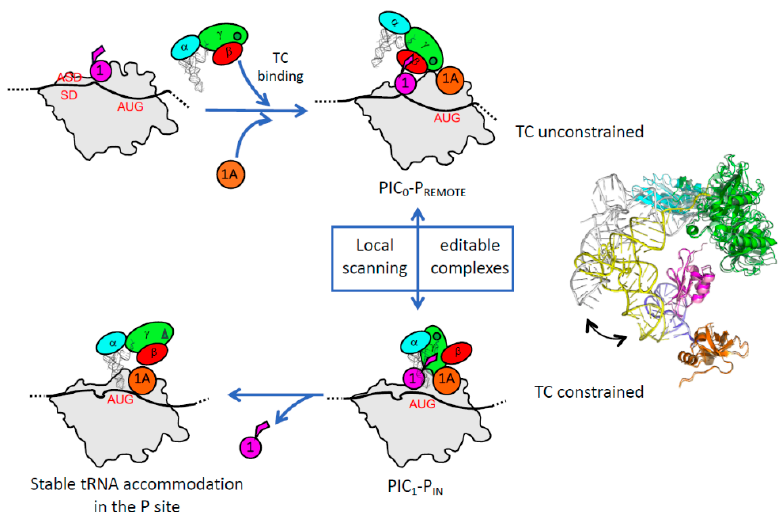
Figure 5. Local scanning for the start codon selection in archaea. The figure schematizes the different steps of the start codon selection for SD containing archaeal mRNAs. Note that aIF1 facilitates the mRNA binding [72,145]. On the right of the figure, the positions of the TC in PIC0–P REMOTE and PIC1–P IN are compared after superimposition of the 30S bodies. The color code is the same as that in Figures 3 and 4, with light colors for PIC0–P REMOTE and dark colors for PIC1–P IN . For clarity, the mobile wings of aIF2 are omitted. The view shows that aIF2 γ does not significantly move in the two conformations, leading to a structural constraint in PIC1-P IN .